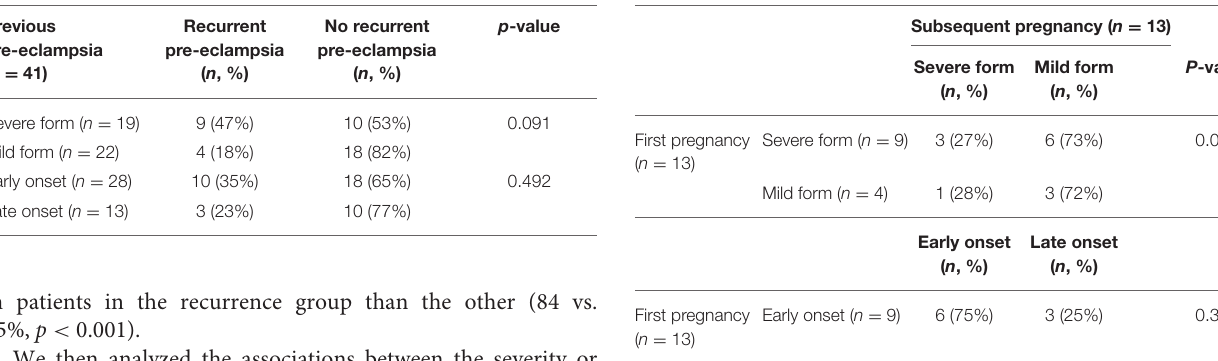
TABLE 3 | Severity or time of onset between first and subsequent pregnancy in patients with recurrent